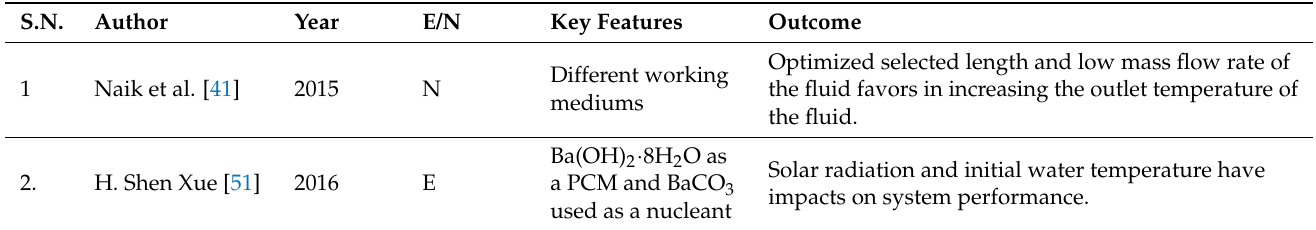
Table 2. Selected literature pertaining to U-tube ETC-PCM/nanofluid-based